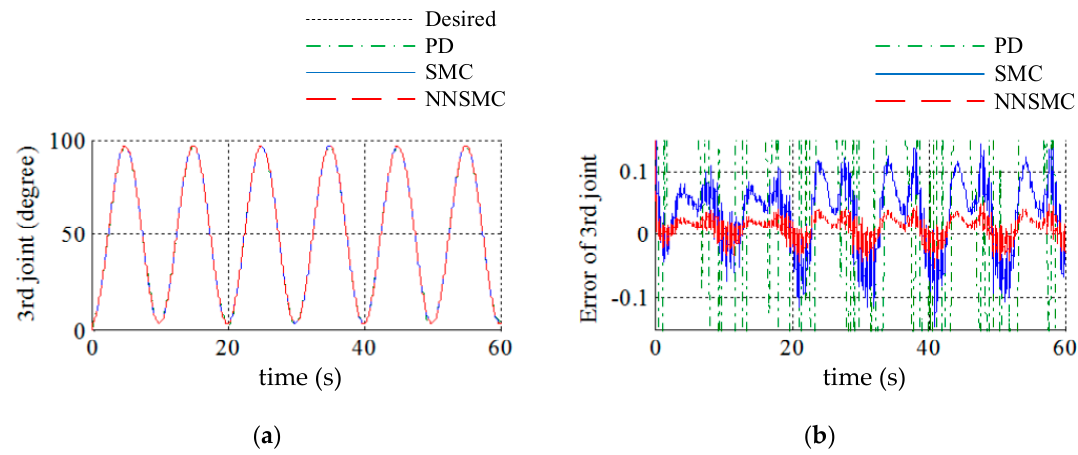
Figure 8. Comparison of tracking performance of the third joint: ( a ) tracking position, ( b ) tracking